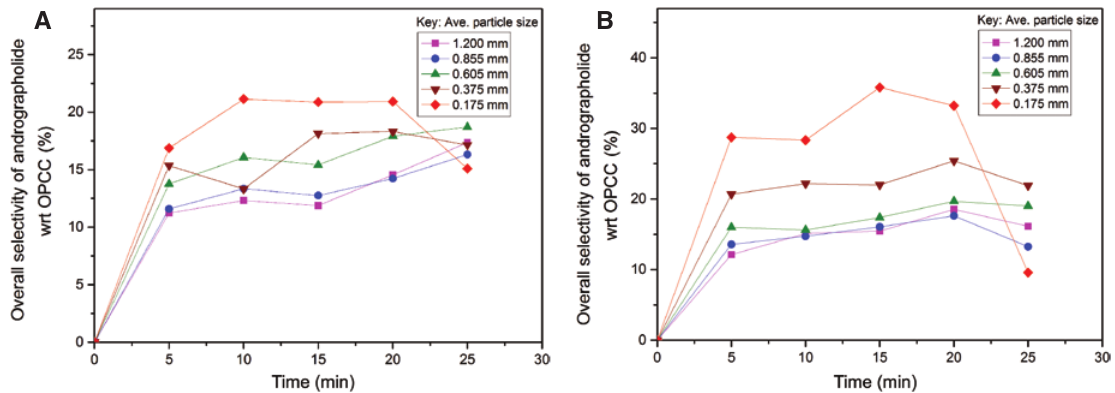
Figure 8: Effect of particle size on the overall selectivity of andrographolide with respect to other phytochemical compounds from Andrographis paniculata (AP) in the green solid-liquid extraction at 80 ° C for solid-liquid ratio of (A) 1:10 (g ml -1 ) and (B) 1:50 (g ml -1